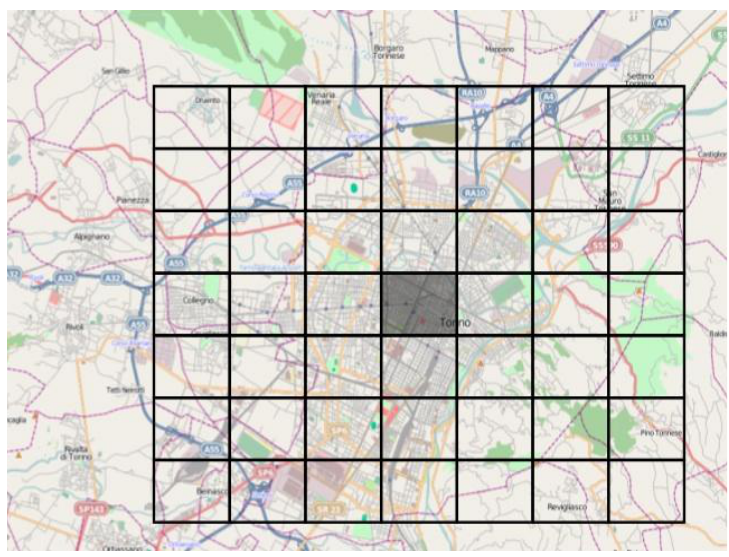
Figure 14. The area of interest with the surrounding grid cells.